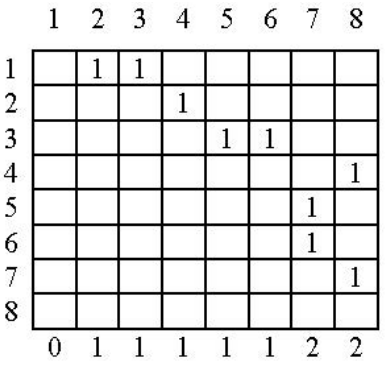
Figure 4. An example matrix of precedence relationships.